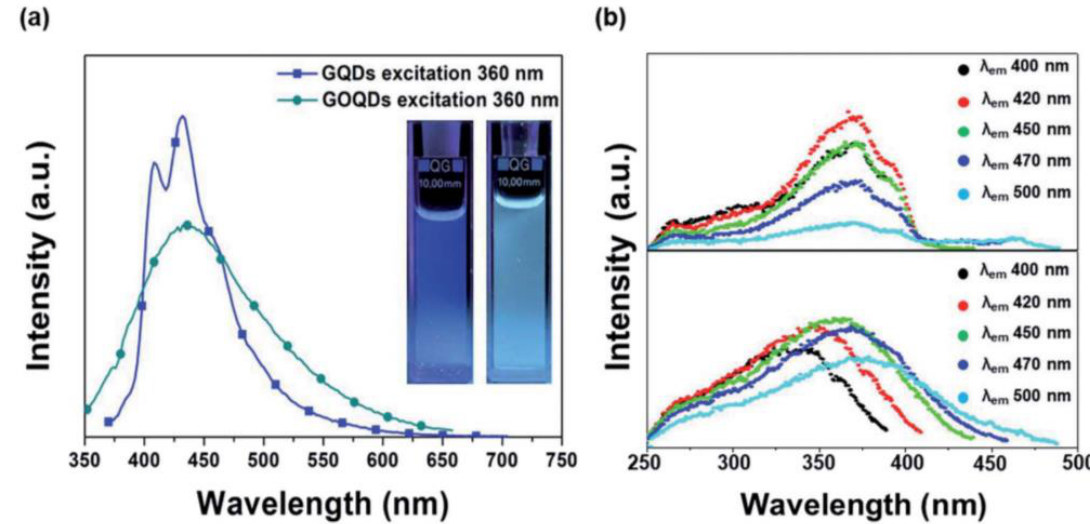
Figure 14. ( a ) PL spectra of GQDs and GOQDs and ( b ) their excitation dependency [68]. FT-IR spectra are utilized to study the different chemical bonds of materials. When analyzing the FT-IR spectra of carbon nanostructures in the 500–4000 cm − 1 range, distinct troughs are observed. The trough positioned at 3420 cm − 1 is related to the O–H stretching vibrational mode, 2930 cm − 1 is ascribed to the C–H stretching, 1633 cm − 1 is attributed to aromatic bending of C=C bonds and C=O stretches, and 1068 cm − 1 is a characteristic of